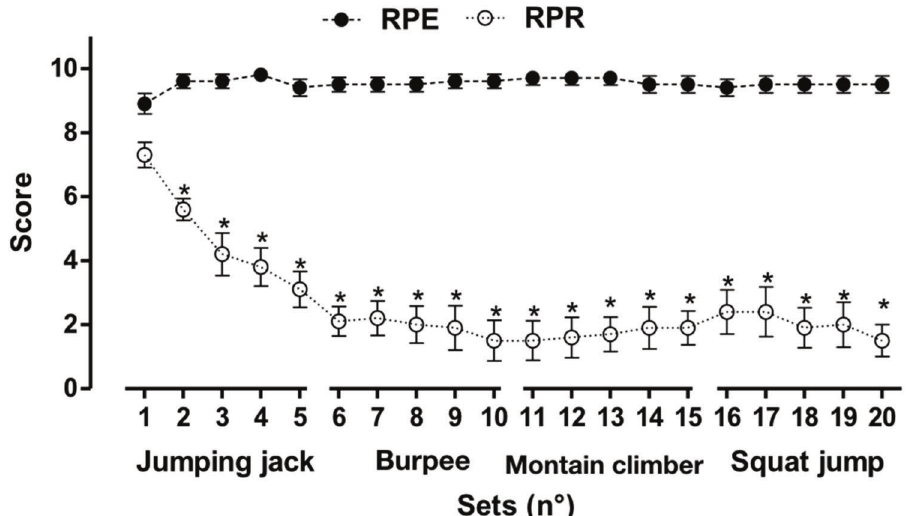
Figure 5 - Values are presented as the means ± standard deviations of the ratings of perceived exertion (RPE) and recovery (RPR) immediately after and before each exercise set. * p o 0.001 vs . the first